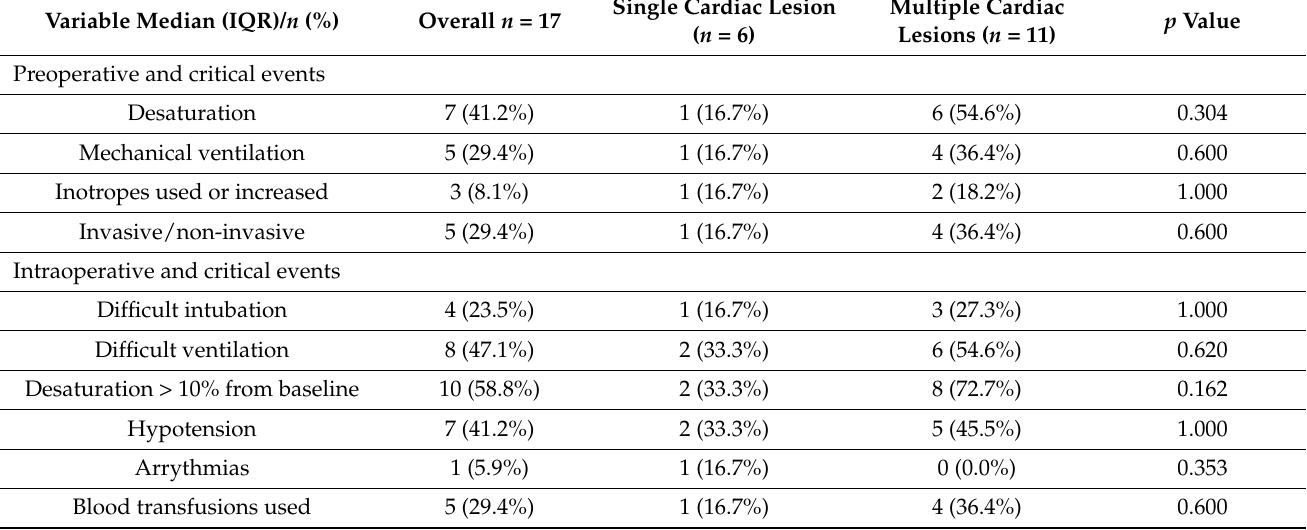
Table 5. Perioperative complications and outcomes between neonates with single and multiple congenital cardiac